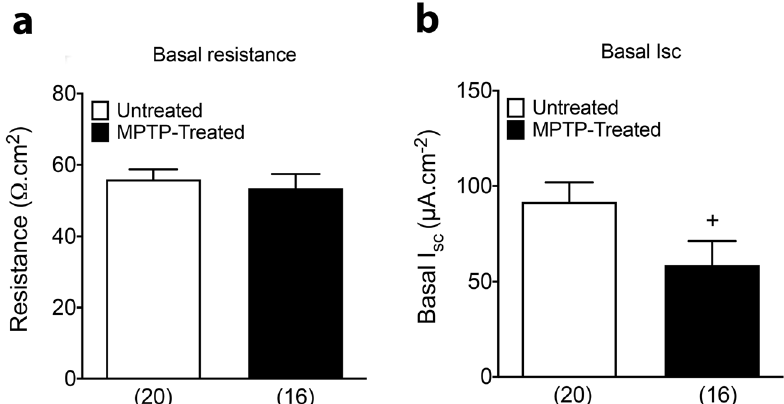
Fig. 1 Basal resistance and I SC levels in the transverse colon from untreated and MPTP-treated common marmosets. a Basal resistance; b short circuit current (I SC ). Values are mean ± SEM from 4 or 5 specimens, as shown in parenthesis ( n = 4 MPTP and n = 5 control). + P ≤ 0.05 compared to untreated animals (Student ’ s t